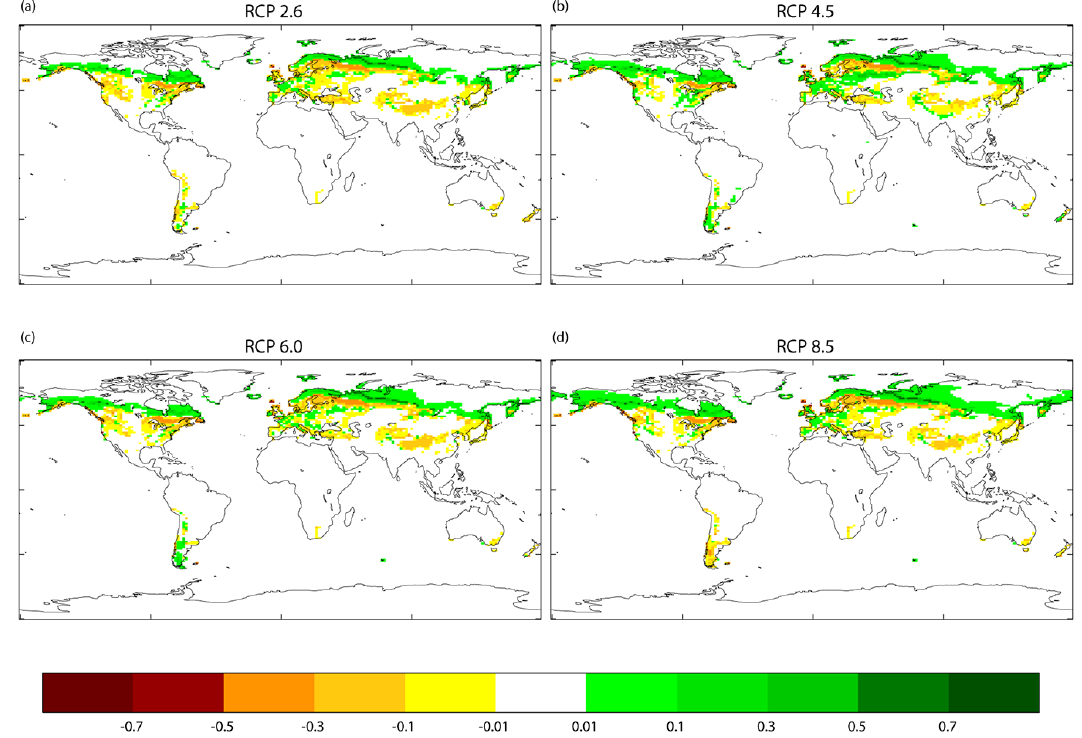
Figure 7. Changes in fractional cover of needleleaf tree by 2070–2099 relative to 1971–2000 simulated by HadGEM2-ES driven by scenarios of greenhouse gas and aerosol concentrations and land use following (a) RCP2.6 (b) RCP4.5 (c) RCP6.0 and (d)